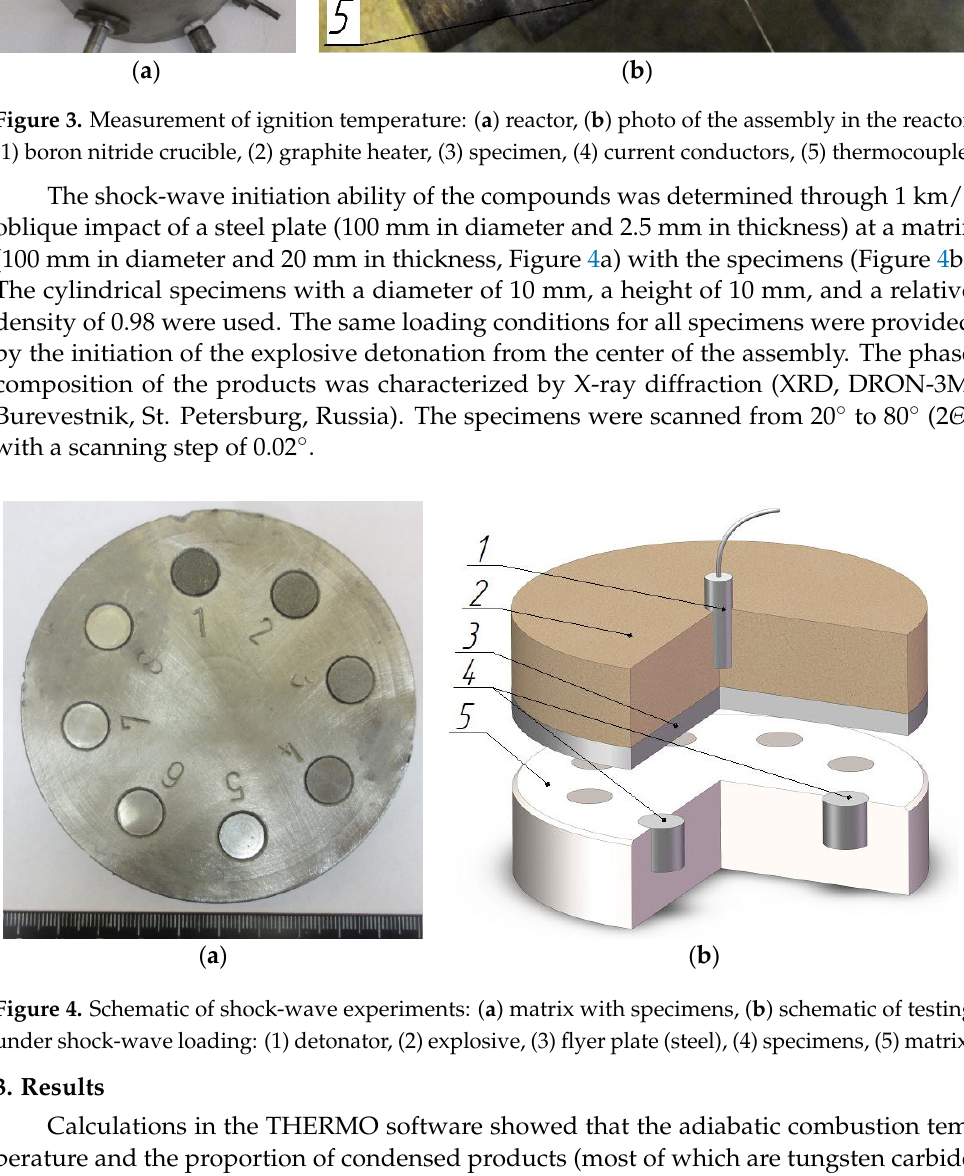
Figure 3. Measurement of ignition temperature: ( a ) reactor, ( b ) photo of the assembly in the reactor: (1) boron nitride crucible, (2) graphite heater, (3) specimen, (4) current conductors, (5) thermocouple.